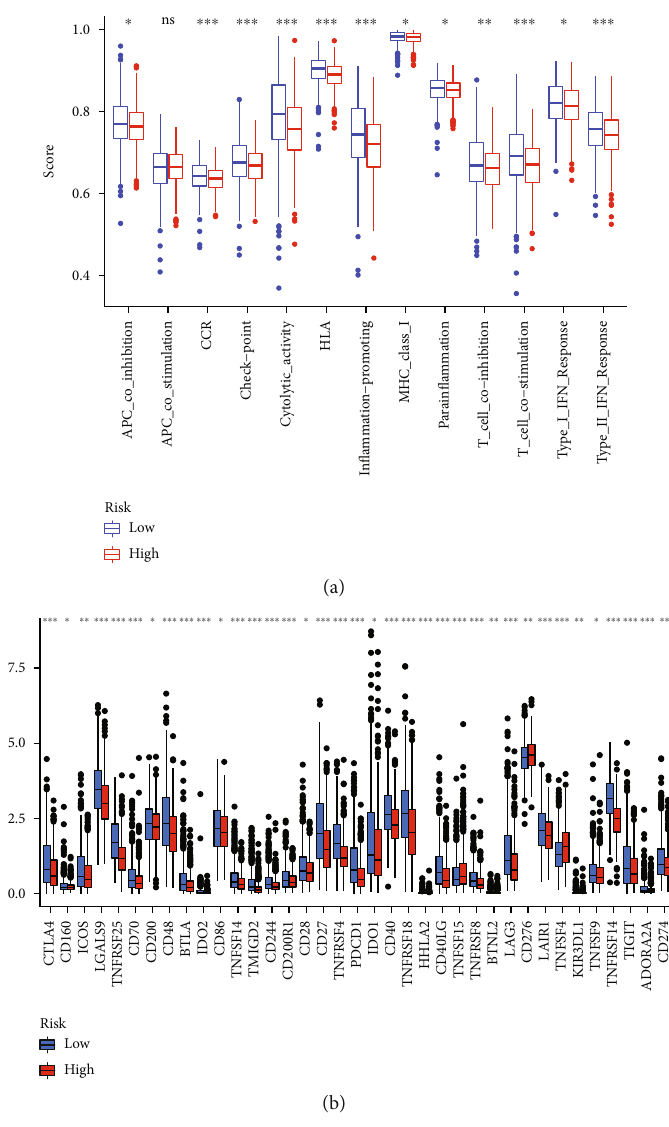
Figure 10: Analysis of immune-related functions and immune checkpoint expression in patients at high and low risk. (a) Correlations between predictive signature and immune-related functions. (b) Di ff erences in immune checkpoint expression levels among di ff erent groups. ∗∗∗ P < 0 : 001 , ∗∗ P < 0 : 01 , ∗ P < 0 : 05